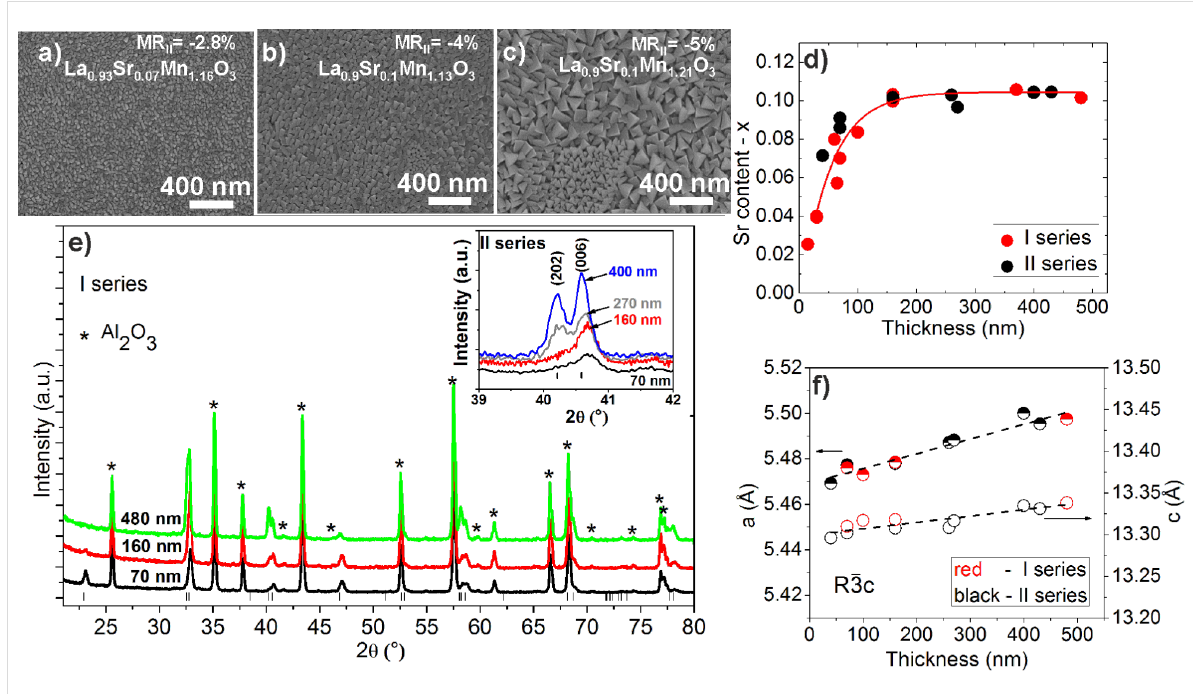
Figure 2: (a–c) SEM pictures of LSMO films (I series) deposited on Al 2 O 3 substrates with different thickness: (a) 70 nm, (b) 160 nm and (c) 480 nm. (d) The average strontium ( x ) content (deduced from ICP-MS measurements) dependence on the thickness of the deposited LSMO films (I and II series, the red line is a guide for the eye). (e) GIXRD patterns for the LSMO films of different thickness for the I series. The inset presents peaks and their shift with thickness for the II series. The stars represent the characteristic peaks of the Al 2 O 3 substrate, the vertical lines represent the character- istic peaks of LSMO in rhombohedral distortion. (f) The a and c lattice parameters calculated from XRD patterns for LSMO films of both